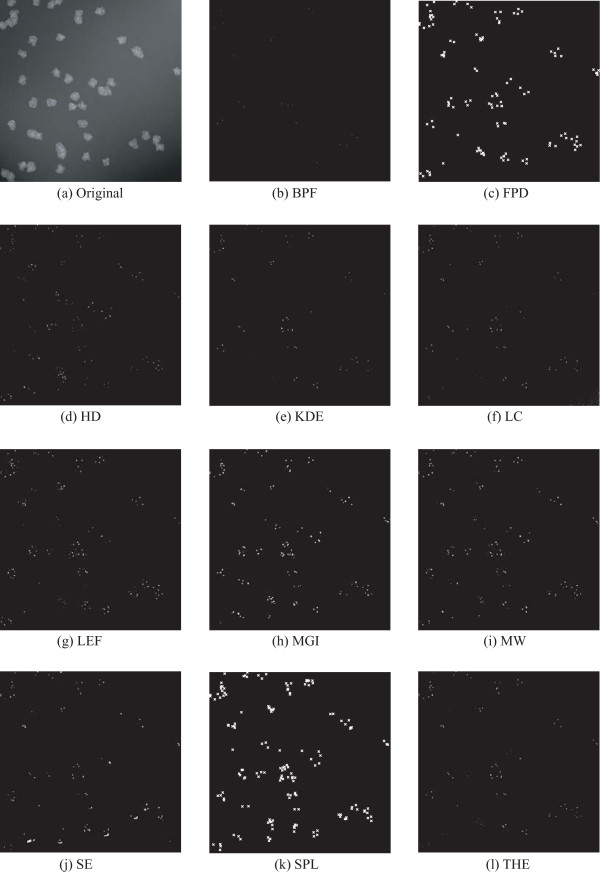
Examples of detection results for a simulated image. Note that for FDP and SPL, the detection has been visualized as a cross centered in the detected point. For others, the result is shown as a binary segmentation mask.